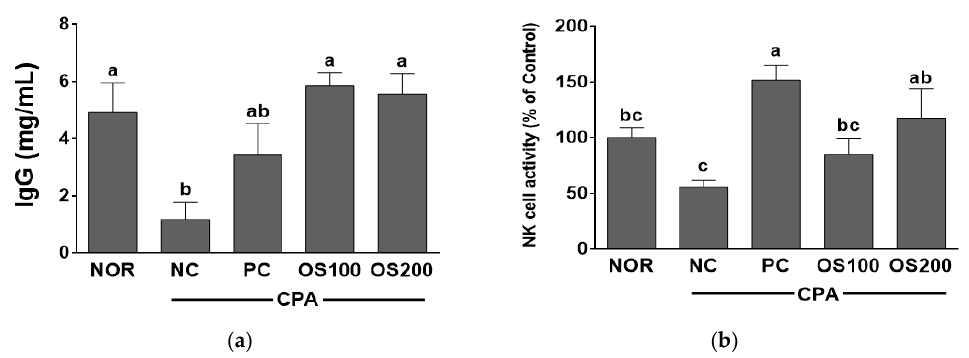
Figure 7. Effects of A. cepa skin (OS) extract on the serum ( a ) IgG level and ( b ) NK cell activity in C57BL/6 mice immunosuppressed by cyclophosphamide (CPA). NOR, normal control group; NC, negative control group; PC, positive control group; OS100, OS extract 100 mg/kg BW; OS200, OS extract 200 mg/kg BW. Data was expressed as the mean ± SEM. a–c Different letters are significantly different at p < 0.05.